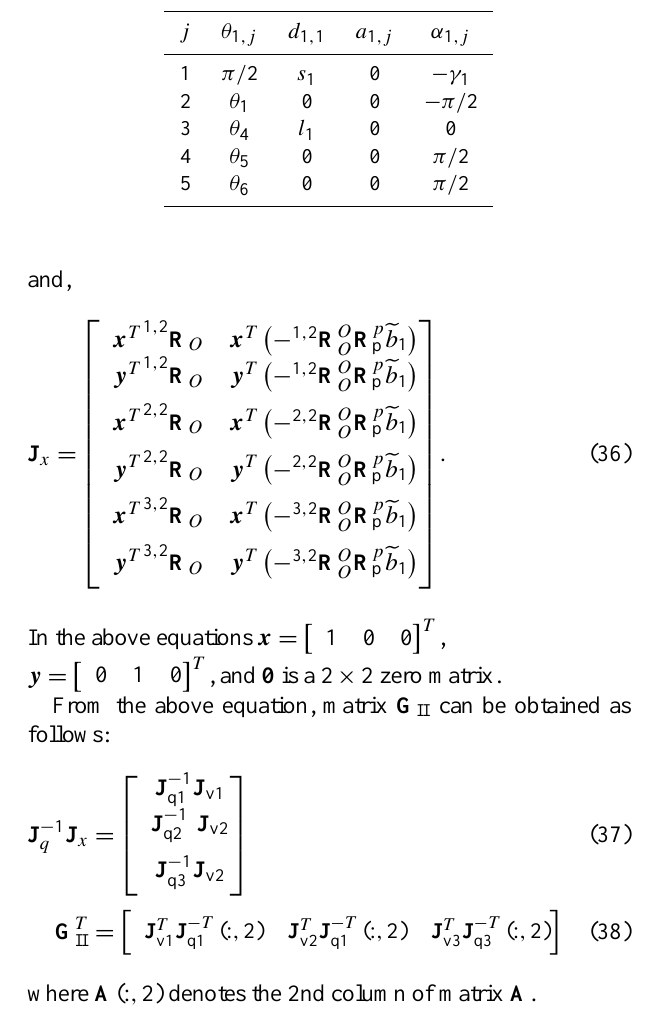
Table 2. D–H Parameters for the first leg of the 3-PRS PM when modelling as a three open